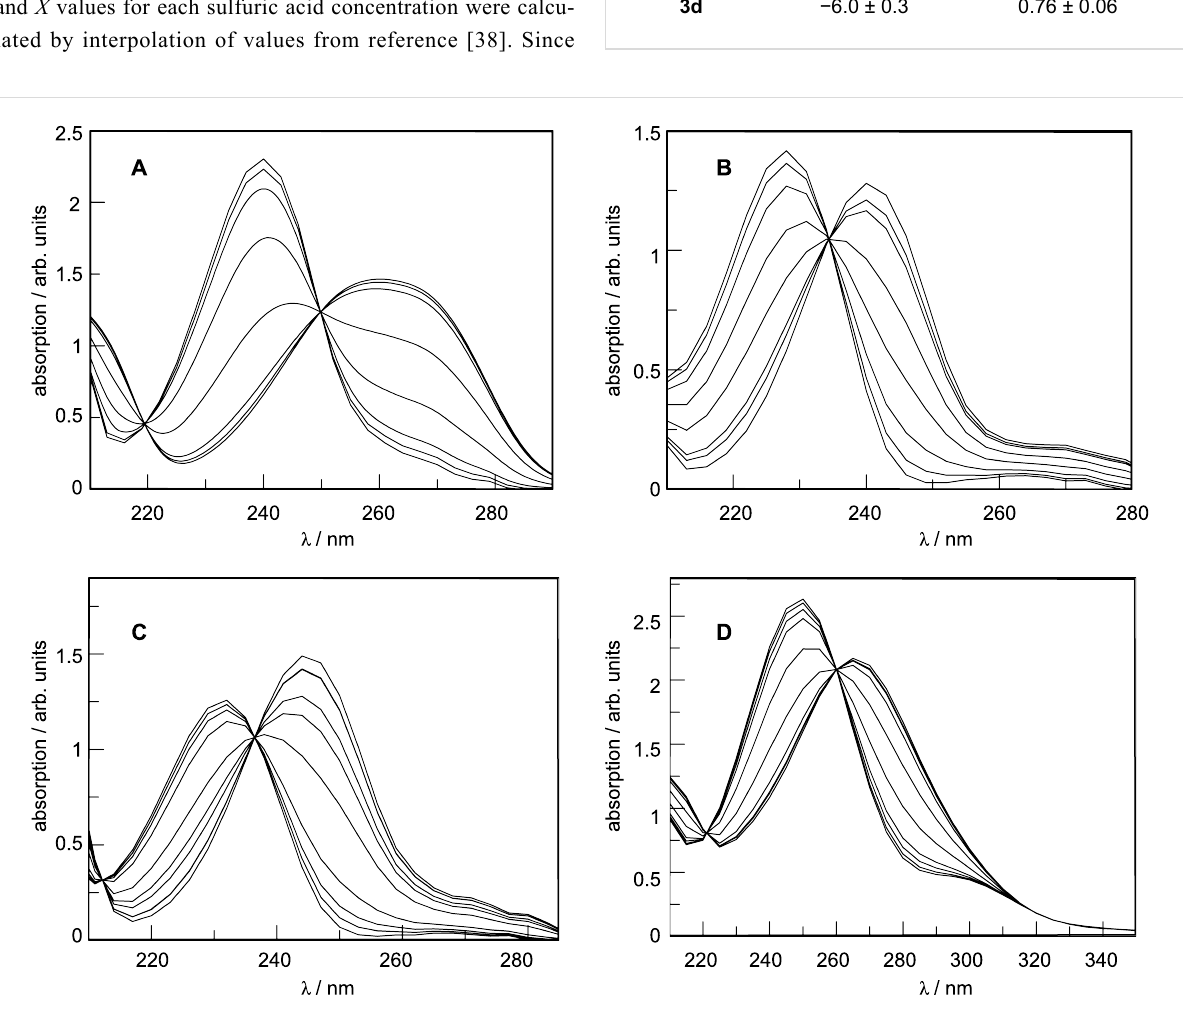
Figure 2: post-CVA absorption spectra at 25 °C of 5 × 10 − 5 M aqueous sulfuric acid solutions of: (A) 3a , (B) 3b , (C) 3c , and (D) 3d . Acid concentra- tion varies between 0 and 97% (w/w).